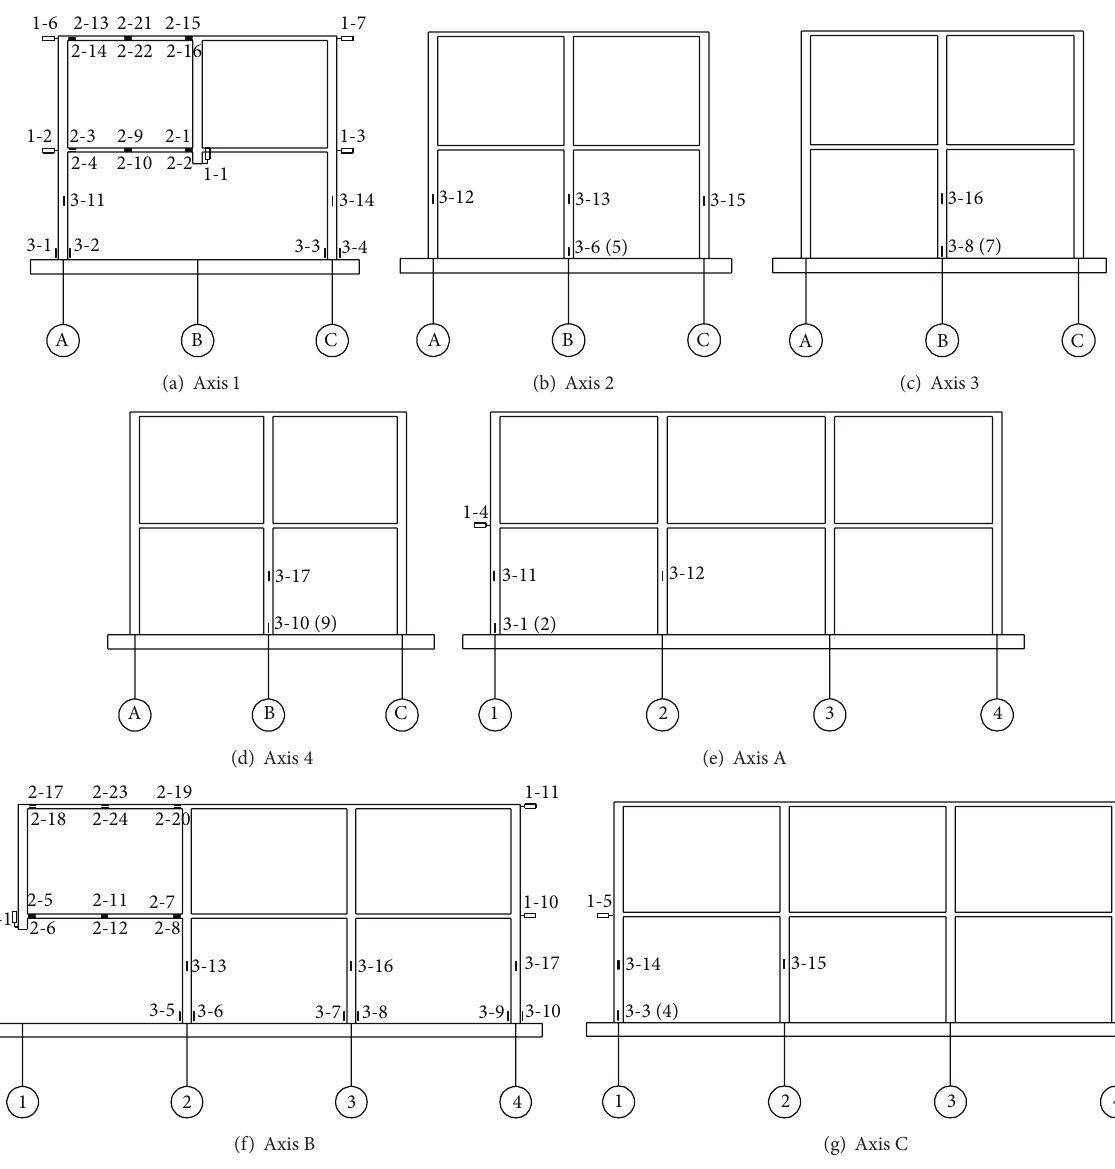
Figure 6: Details of testing setup and instrumentation. (Note: 1-1 to 1-11: displacement transducers; 2-1 to 2-24: steel strain gauges; 3-1 to 3-17: concrete strain